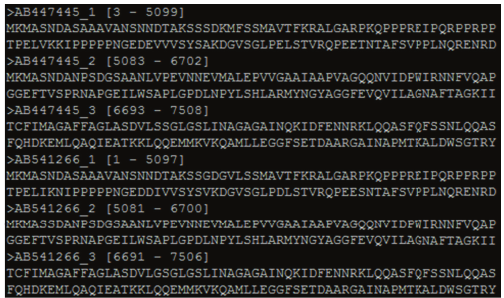
Figure 6: An example of ORFs detected by ORF finder.